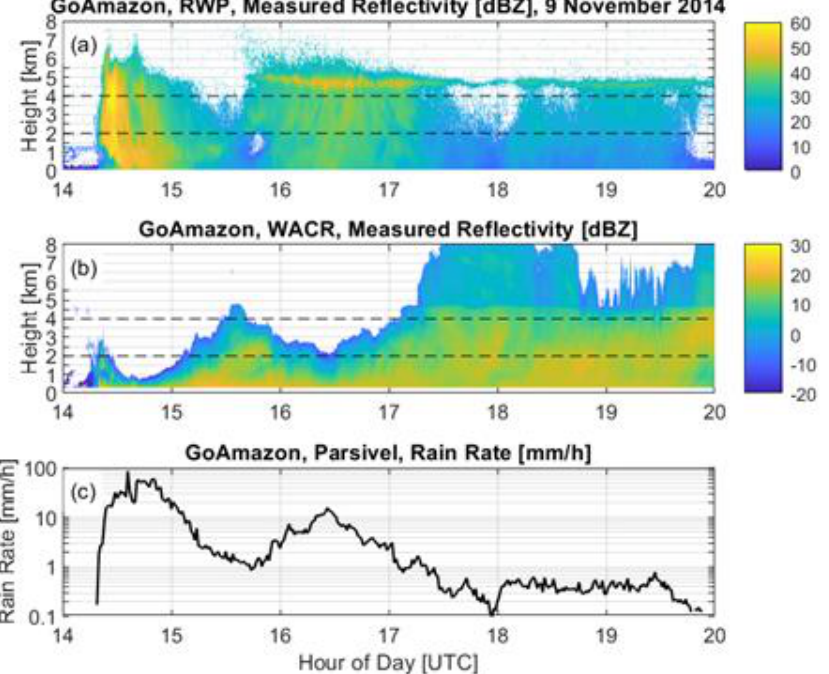
Figure 1. Measured radar reflectivity factor from vertically pointing radars (VPRs) deployed near Manaus, Brazil, during the DOE GOAmazon field campaign from an event on 9 November 2014. ( a ) Radar Wind Profiler (RWP) operating at 1.2 GHz and ( b ) W-band ARM Cloud Radar (WACR) operating at 95 GHz. ( c ) Surface Parsivel disdrometer rain rate.